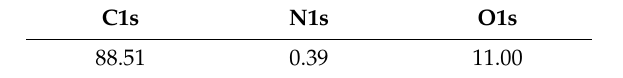
Table 2. The mean element content of FLG nanosheets were measured 3 times by elemental analyzer.